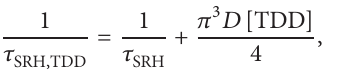
Table 1: Material properties for CuIn 1−𝑥 Ga 𝑥 Se